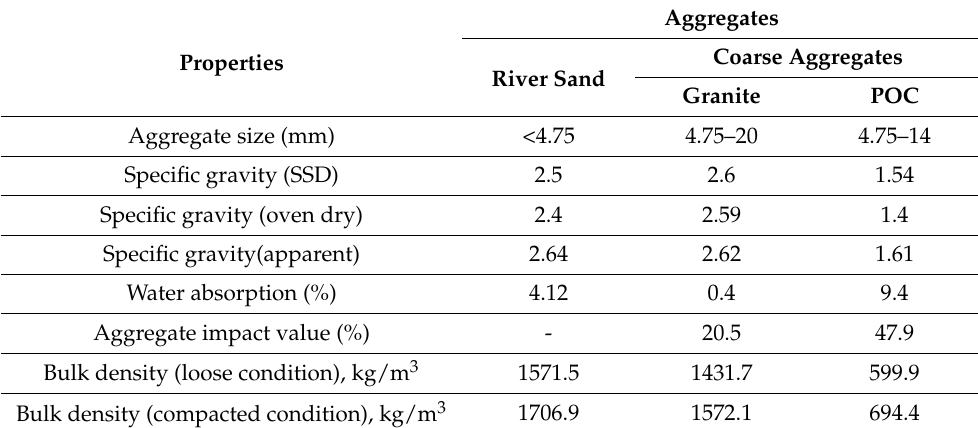
Table 1. Physical characteristics of river sand, granite, and palm oil